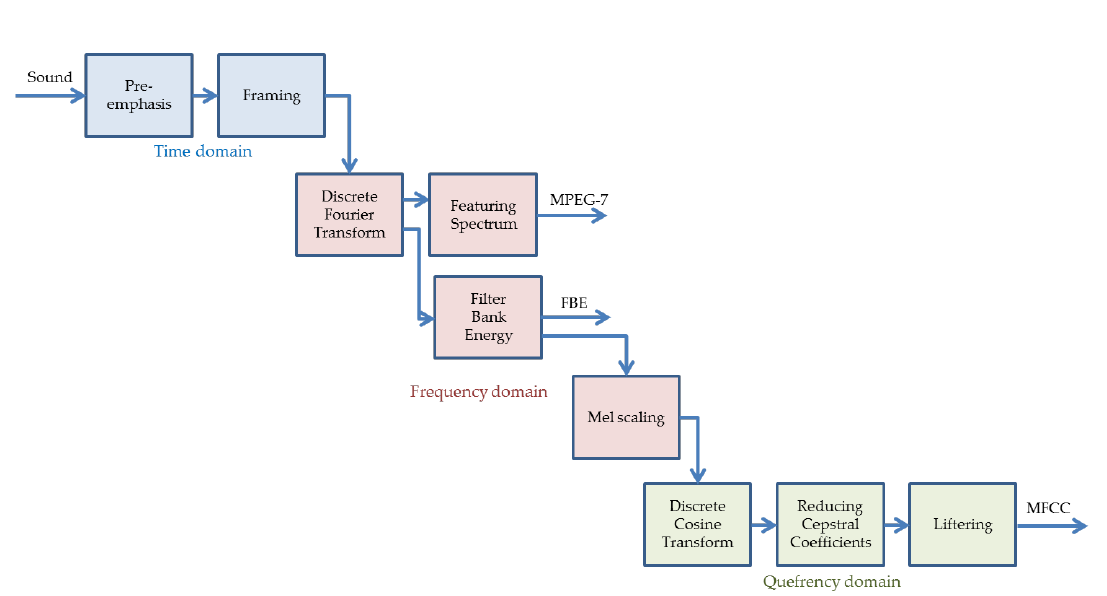
Figure 17. Overall structure of the process for the representation of a spectrum.